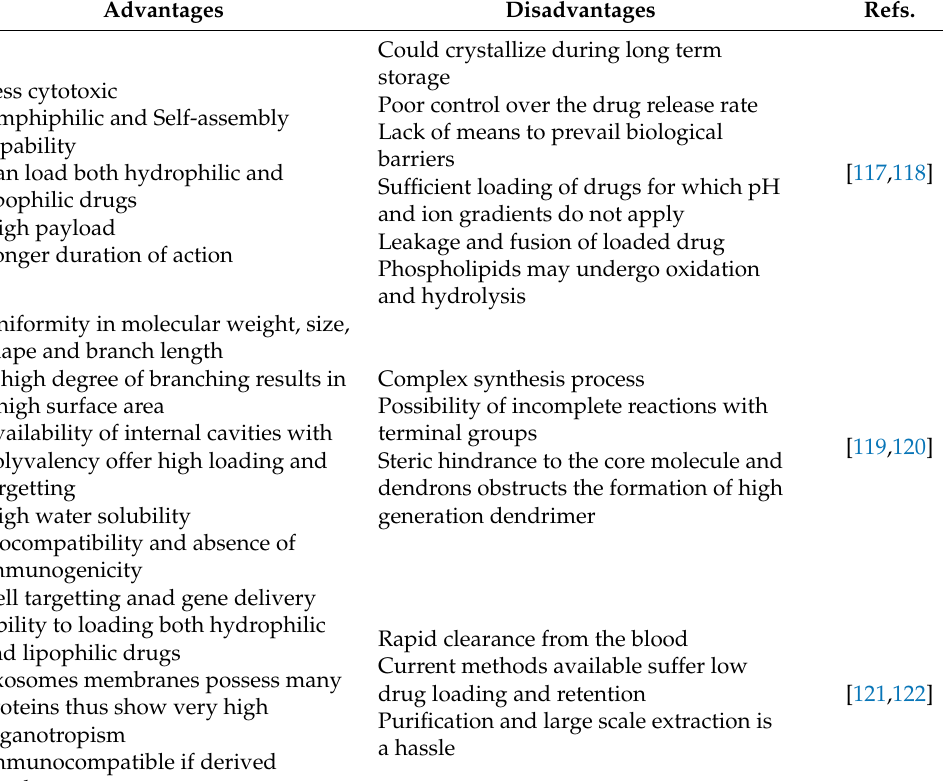
Table 10. Advantages and disadvantages of various nanocarriers in drug